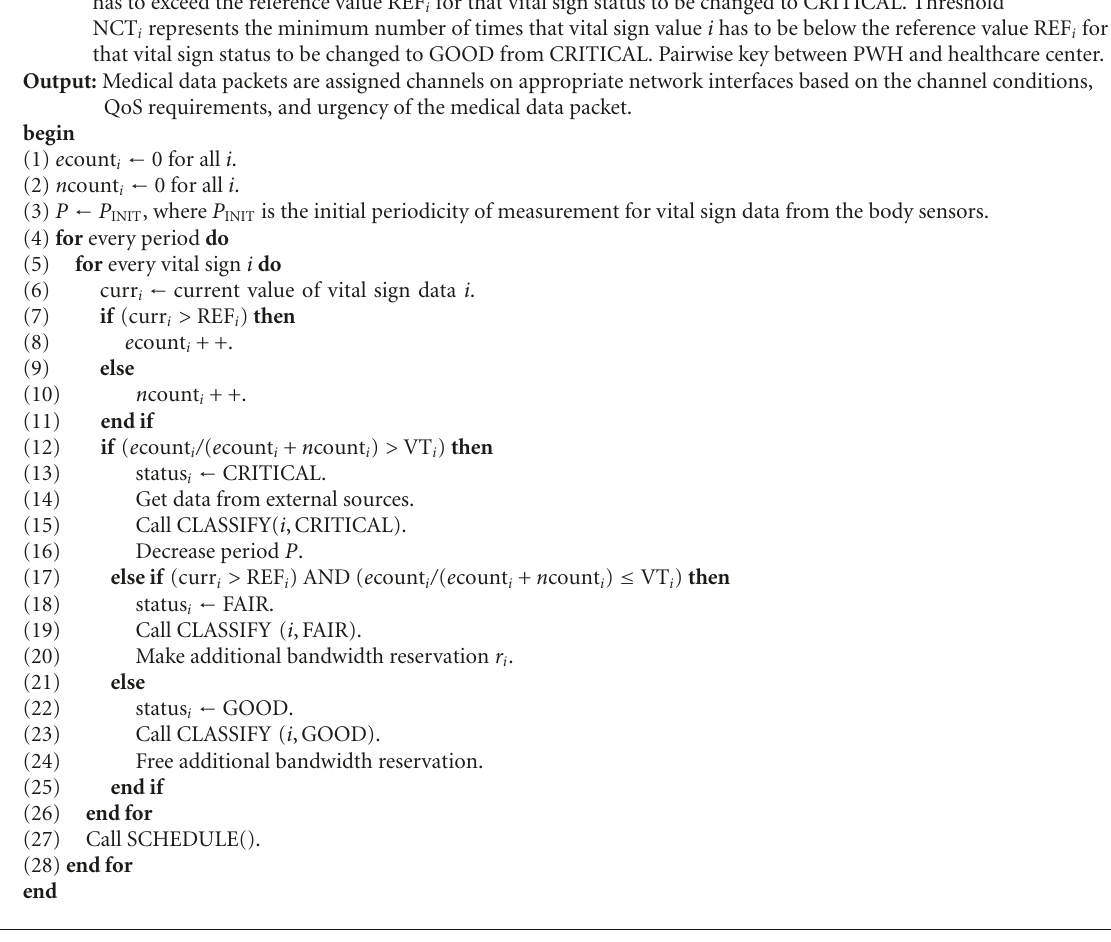
Algorithm 1: Algorithm